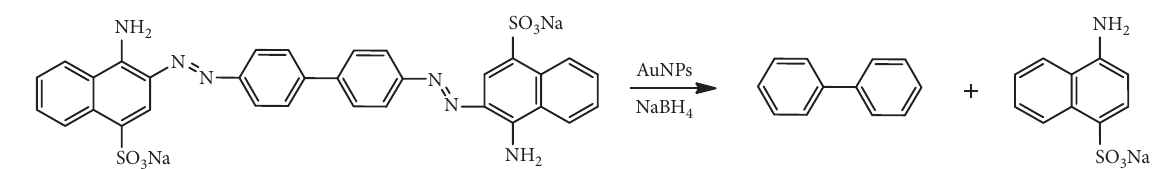
Figure 1: Catalytic reduction of CR by NaBH